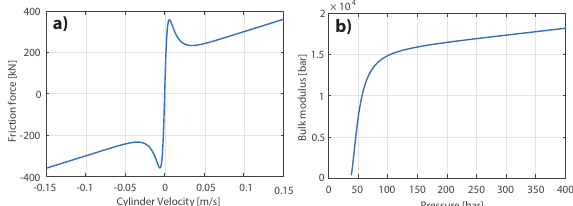
Figure 6: a) Friction force as a function of cylinder ve- locity with ∆ p = 220 bar. b) Effective bulk- modulus as function of